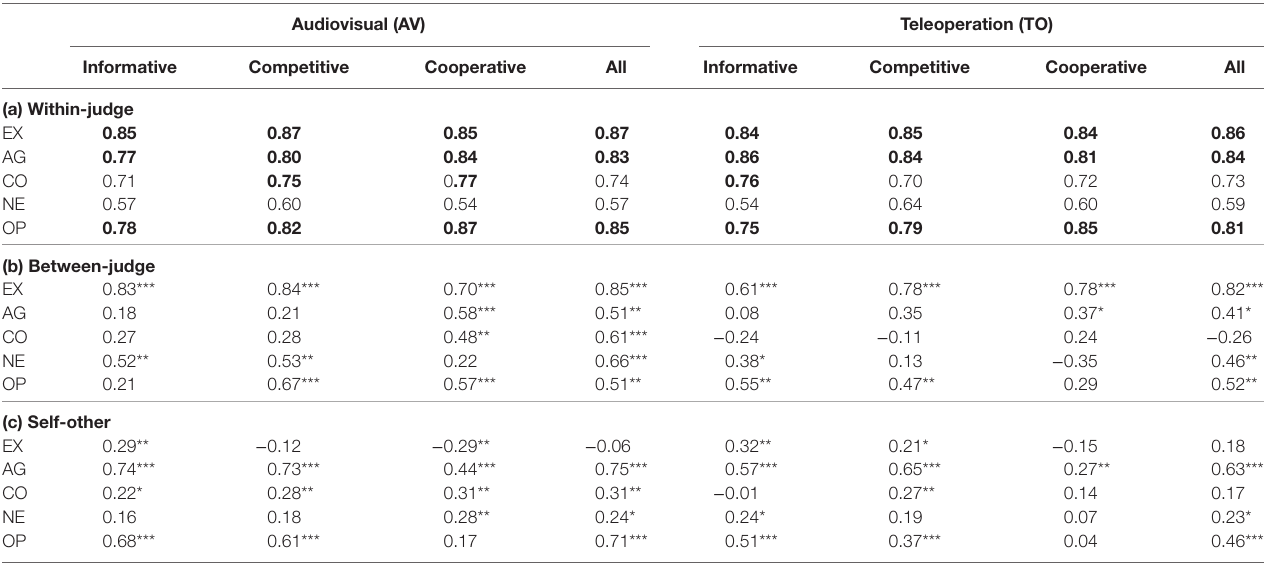
TaBle 4 | analysis of personality judgments across 2 communication conditions and 3